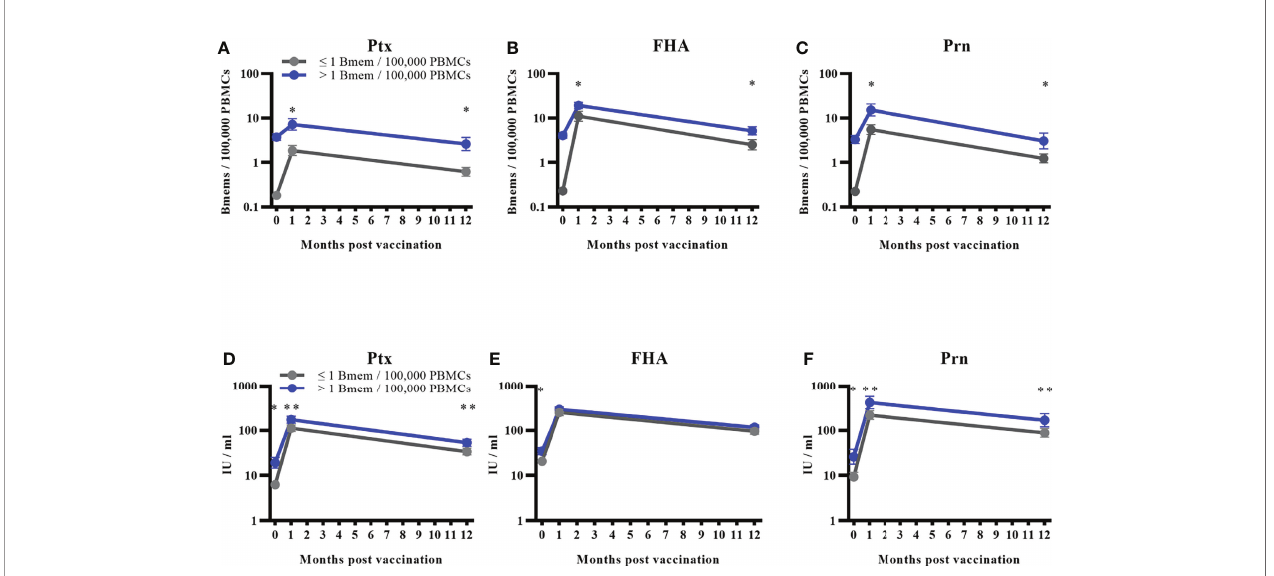
FIGURE 5 | Memory B cell responses to different antigens based on a de fi ned frequency cut-off of > 1 memory B cell/100,000 PBMCs. Bmems: memory B cell frequencies; PBMCs, peripheral blood mononuclear cells. Geometric mean memory B cell frequencies with 95% con fi dence intervals for the combined age groups distributed into two groups based on baseline memory B cell frequencies for (A) pertussis toxin; (B) fi lamentous haemagglutinin; and (C) pertactin. Corresponding antibody geometric mean concentrations for the two groups for (D) pertussis toxin, (E) fi lamentous haemagglutinin; and (F) pertactin. Number and proportion of participants in the group with frequencies ≤ 1 memory B cell/100,000 PBMCs can be viewed in Table 3 . *p < 0.001; **p =